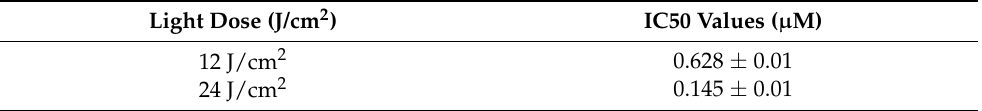
Table 1. IC50 values of ZnPc-PDT in different doses of the light